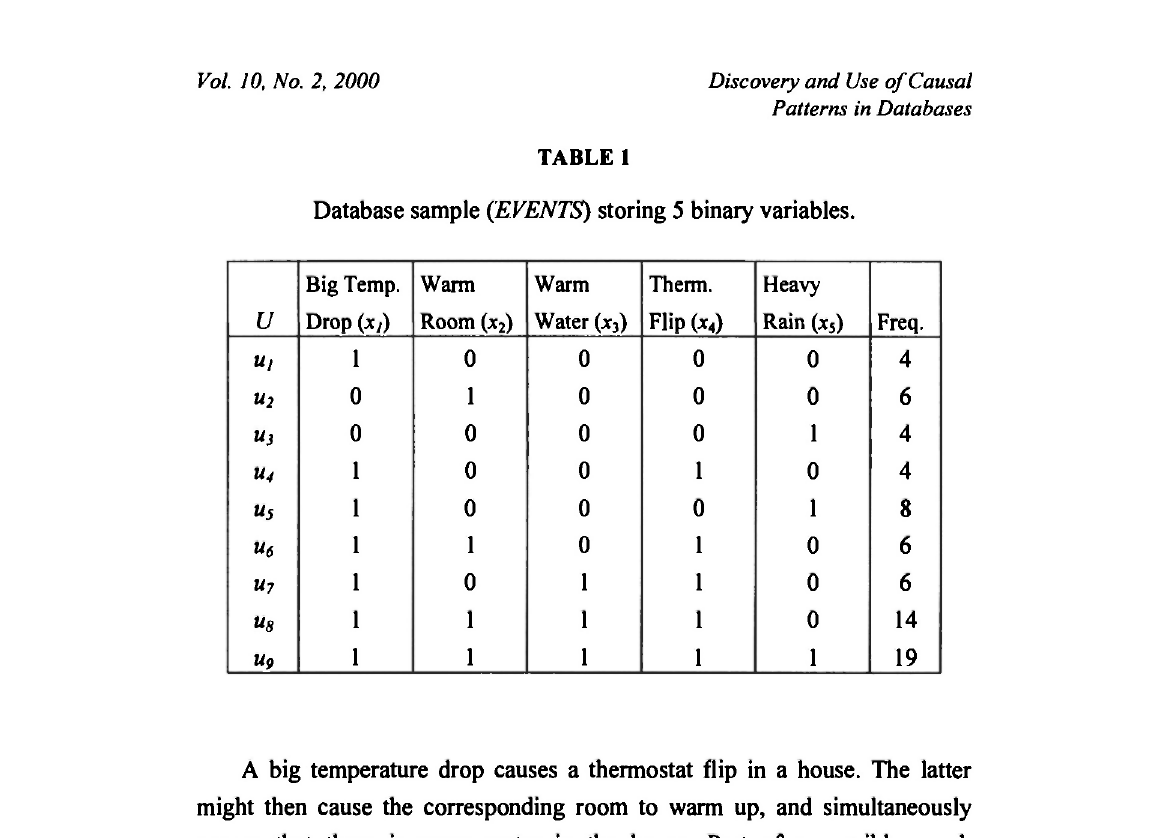
Database sample ( EVENTS) storing 5 binary